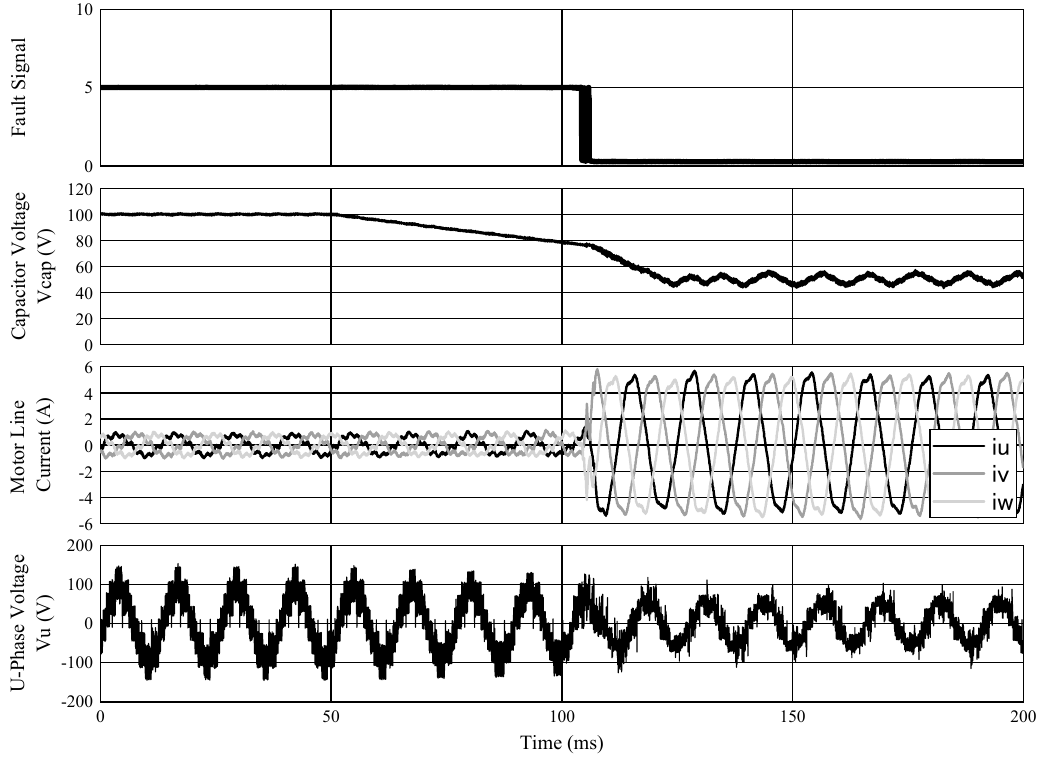
Figure 15. Experimental result of fault tolerant operation of DC-bus battery. Table 3. Measurement results.